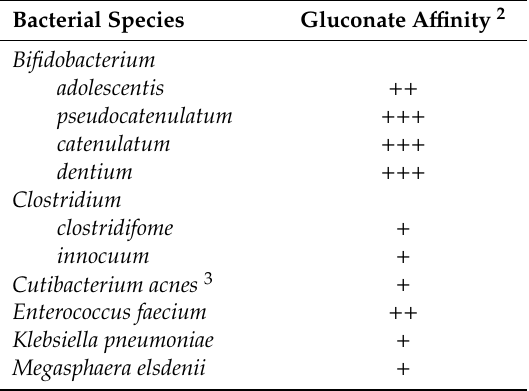
Table 1. Utilization of gluconate by intestinal bacteria